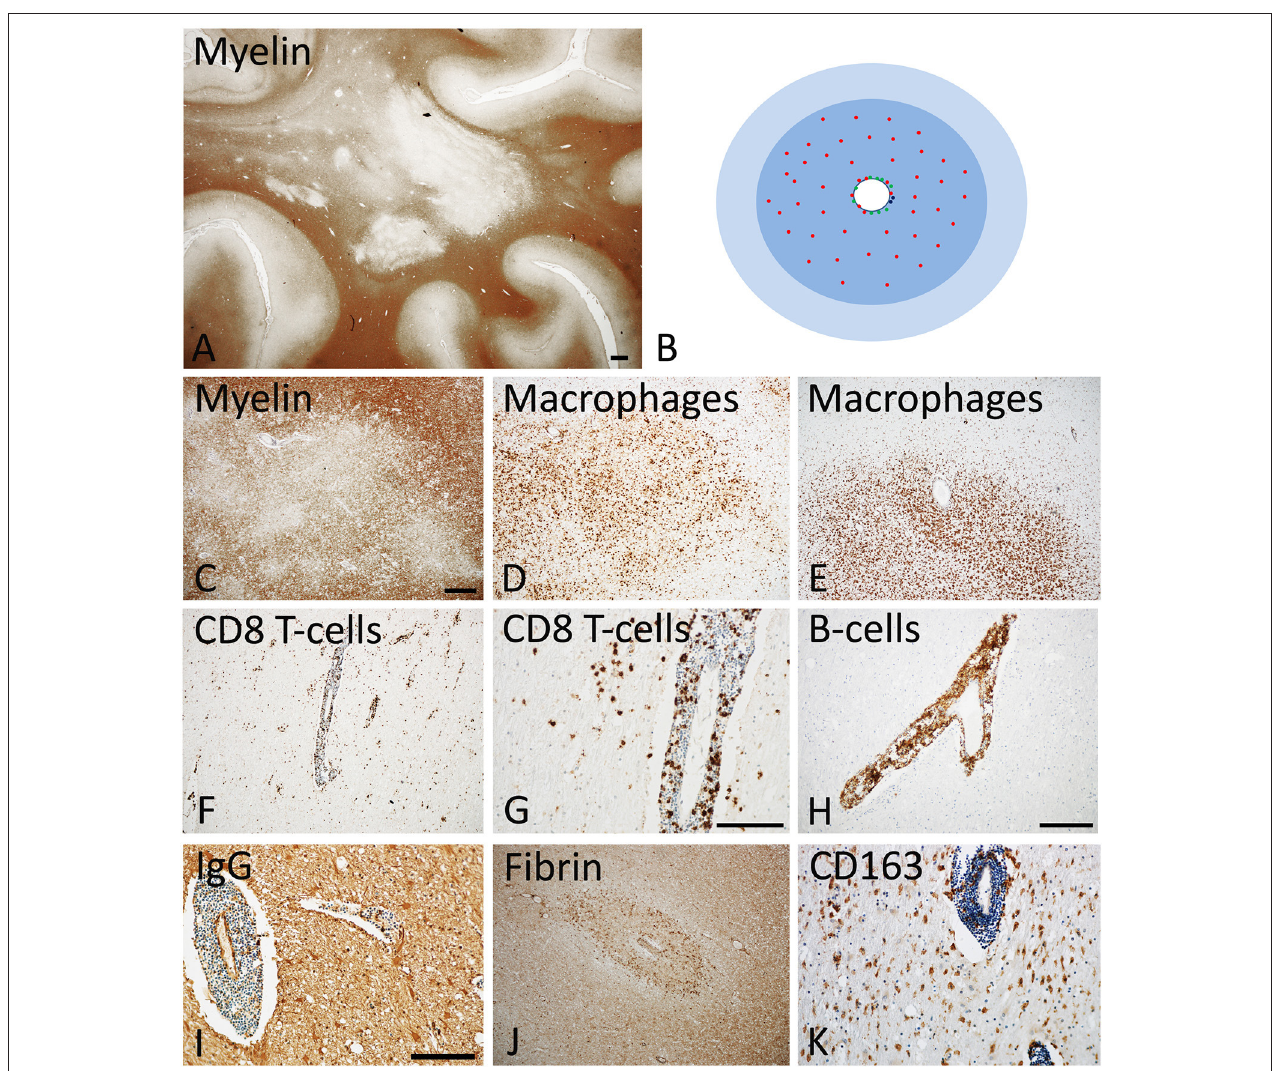
FIGURE 1 | Active Lesions in early MS (acute and RRMS). (A) The dominant pathology in early MS is the presence of focal confluent demyelinated lesions in the white matter, many of them being in the stage of activity; section of a patient with acute multiple sclerosis, stained for myelin by immunohistochemistry for proteolipid protein. Magnification bar: 1mm. (B) The classical active lesions in early MS develop around a central vein with inflammatory infiltrates, composed of CD8 + T-cells (red), CD20 positive B-cells (green), and few plasma cells (blue). While B-cells and plasma cells mainly remain in the perivascular space, the CD8 + T-cells also diffusely infiltrate the lesion parenchyme. The lesion (blue) is massively infiltrated by macrophages. Many of the lymphocytes are in the process of passing the vessel wall and this is associated with profound blood brain barrier leakage. This results in profound edema, which expands beyond the area of active demyelination (light blue). (C–E) Myelin staining (immunocytochemistry for proteolipid protein) shows patchy areas of active demyelination, which is associated with dense infiltration of the tissue by macrophages (D,E) . (F, G) Immunohistochemistry for the T-cell marker CD8 shows perivascular accumulation of T-cells, and their diffuse infiltration of the lesion parenchyme. (H) The perivascular inflammatory infiltrates contain numerous CD20 + B-lymphocytes. (I,J) Staining for IgG reveals massive leakage of the blood brain barrier and only a small number of IgG containing plasma cells in the perivascular space (I) ; the profound blood brain barrier leakage is also reflected by extensive leakage of fibrinogen through the inflamed vessels (J) . (K) A subset of macrophages expresses the activation marker CD163, a feature which is typically found in active MS lesions. The magnification bars in the figures (C,G,I) represent 100 µ m. Similar histological images as shown in this figure have been previously published. Structure of the lesions: Frischer et al. (46); Inflammatory reaction: Frischer et al. (47); Machado Santos et al. (37); Microglia and macrophages: Zrzavy et al. (38); Fibrin and blood brain barrier injury: Hochmeister et al.